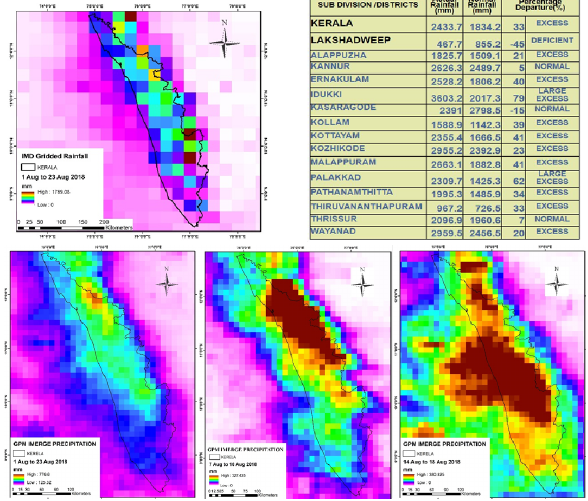
Figure 1. Seasonal Rainfall (in mm) totals in Kerala from